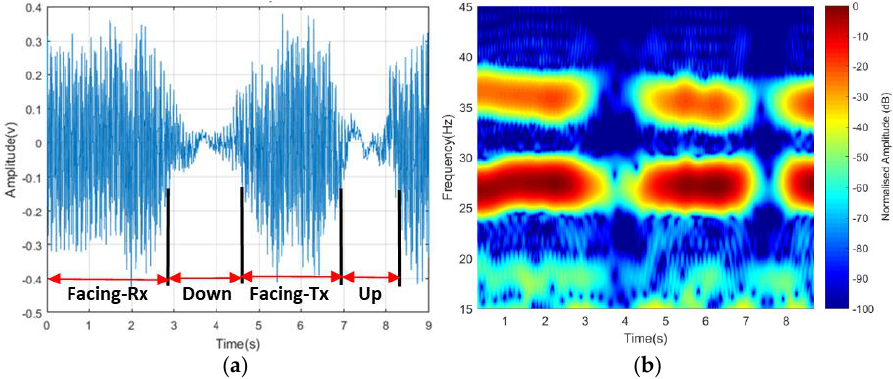
Figure 11. Signal from blade maneuvering in ( a ) time domain and ( b ) its spectrogram